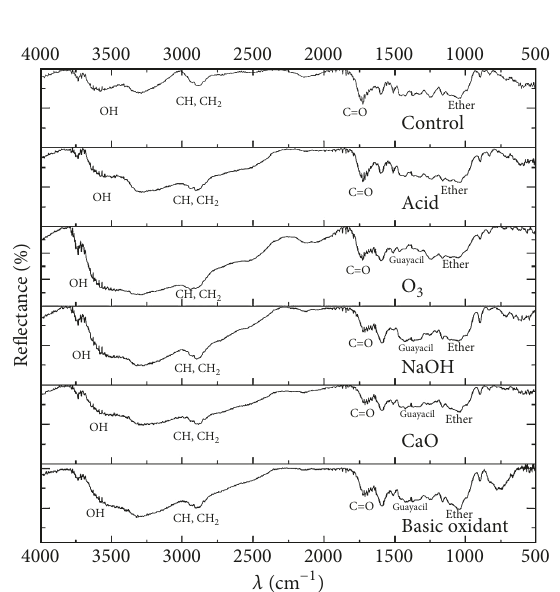
Figure 6: Spectrum of different pretreatments analyzed by infrared